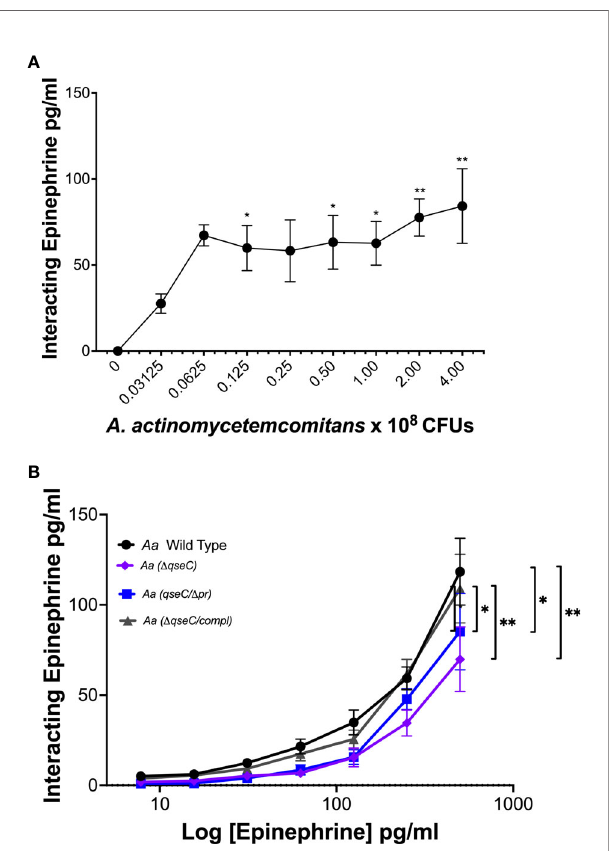
FIGURE 7 | Host-derived epinephrine promotes A . actinomycetemcomitans growth and qseBC expression. The supernatants and lysates from human neutrophils stimulated with latrunculin A and fMLF were collected and used as supplement for chemically de fi ned media (CDM). A . actinomycetemcomitans was grown under anaerobic conditions in CDM alone or supplemented with human neutrophil supernatant (Sup), cell lysate (Lysate), iron (FeCl 2 , 100 m M), or Epinephrine (Epi, 50 m M). At designated times, growth was measured by determining the optical density at 600 nm (OD 600 ) (A) . A . actinomycetemcomitans strain (that harbors the qseBC promoter- lacZ reporter plasmid pDJR29) was grown under anaerobic conditions in CDM alone or supplemented with human neutrophil supernatant (Sup), cell lysate (Lysate), iron (FeCl 2 , 100 m M), or Epinephrine (Epi, 50 m M). Expression of the qseBC operon was determined by measuring b - galactosidase activity after 24 h (B) . The OD 600 measurements for growth were plotted as the mean ± SEM of three independent experiments (A) . The expression of the qseBC operon is presented in miller units as the mean ± SD of three independent experiments (B) . Statistical differences among experimental conditions were analyzed by two-way ANOVA (A) or ordinary one-way ANOVA (B) , followed by Tukey ’ s post-test. ns, not signi fi cant, ** p < 0.01, *** p < 0.001, **** p < 0.0001.